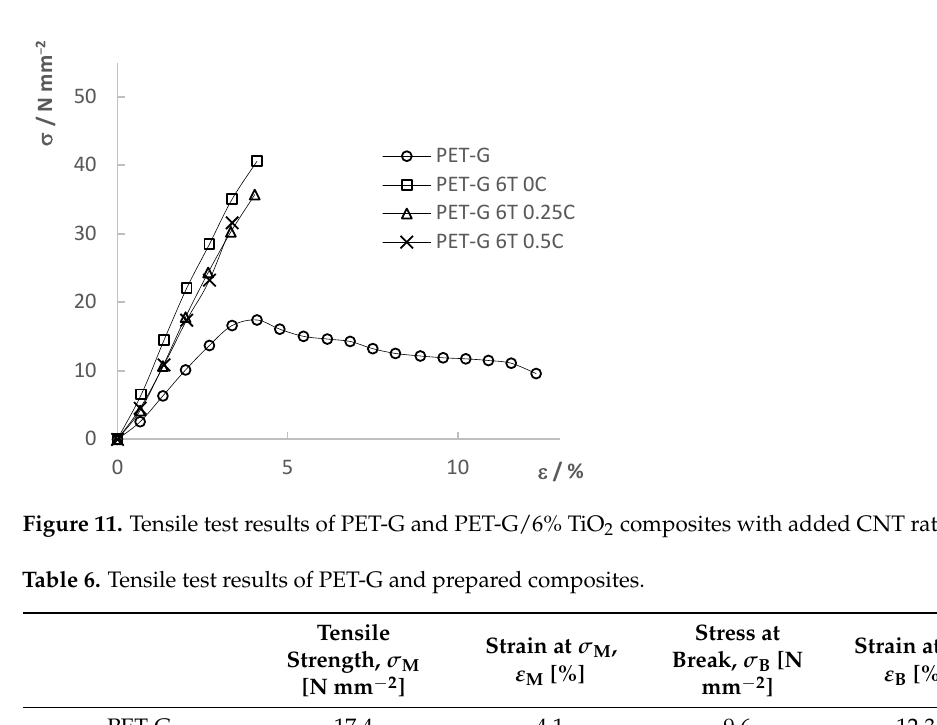
Figure 10. Tensile test results of PET-G and PET-G/3% TiO 2 composites with added CNT ratios .